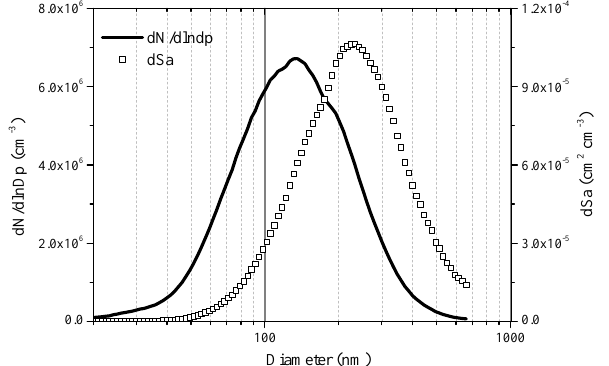
Figure 2. Typical number (left y axis) and surface (right y axis) size distribution (mobility diameter, measured by the SMPS) of TiO 2 aerosols used in this